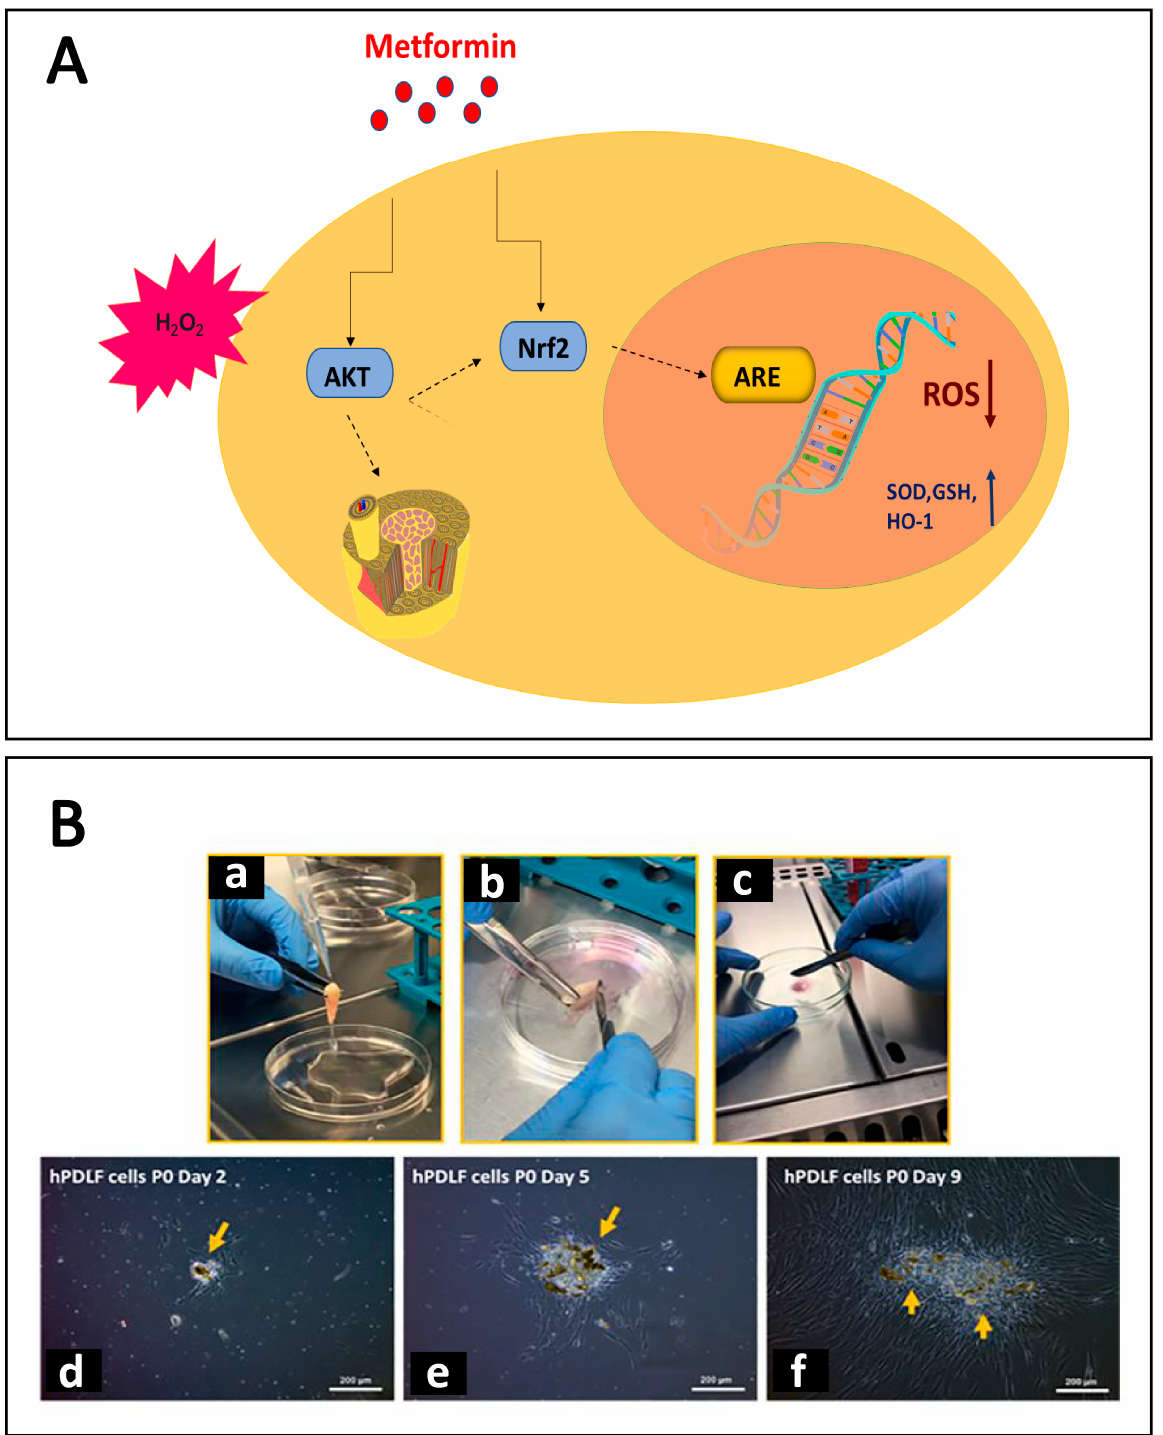
Figure 3. ( A ) The effect of metformin in promoting osteogenic differentiation and protecting against ROS through stimulation of the Akt/Nrf2 signaling pathway in cells, ( B ) Separation of human periodontal ligament fibroblast cells (hPDLFCs) ( a – c ), the effect of EPS on cell viability after 2, 5, and 9 days ( d – f ), yellow arrows indicate the cell colonies, (Reprinted/adapted with permission from Ref. [112] 2020, Elsevier).